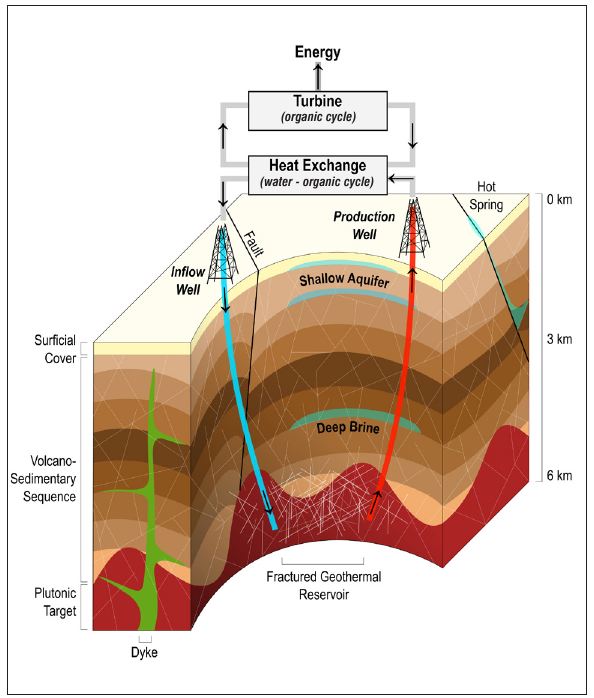
Figure 1: Schematic illustration of a binary fluid enhanced geothermal system related to surrounding fracture-controlled geological